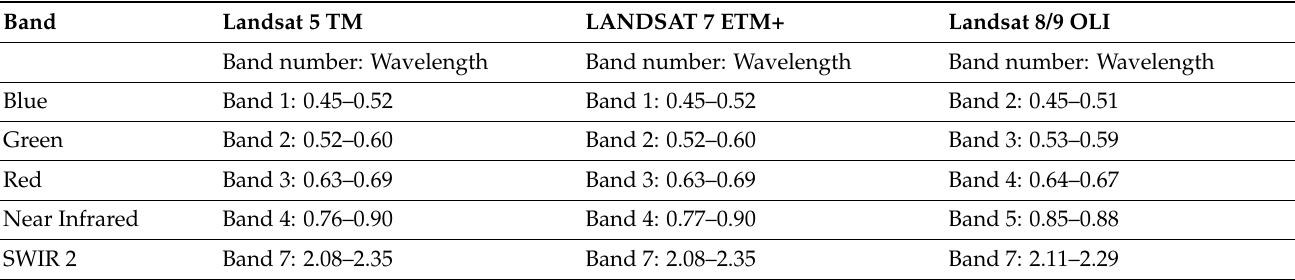
Table 3. The 30 m Spatial Resolution